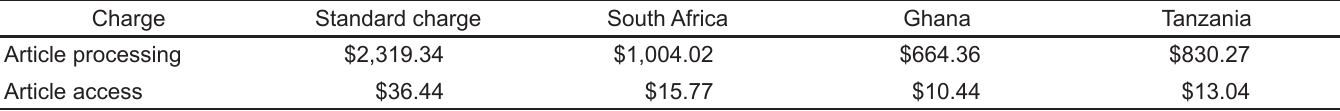
Table. Representative article access and processing fees for South Africa, Ghana and Tanzania that would result in similar out-of- pocket spending to the United